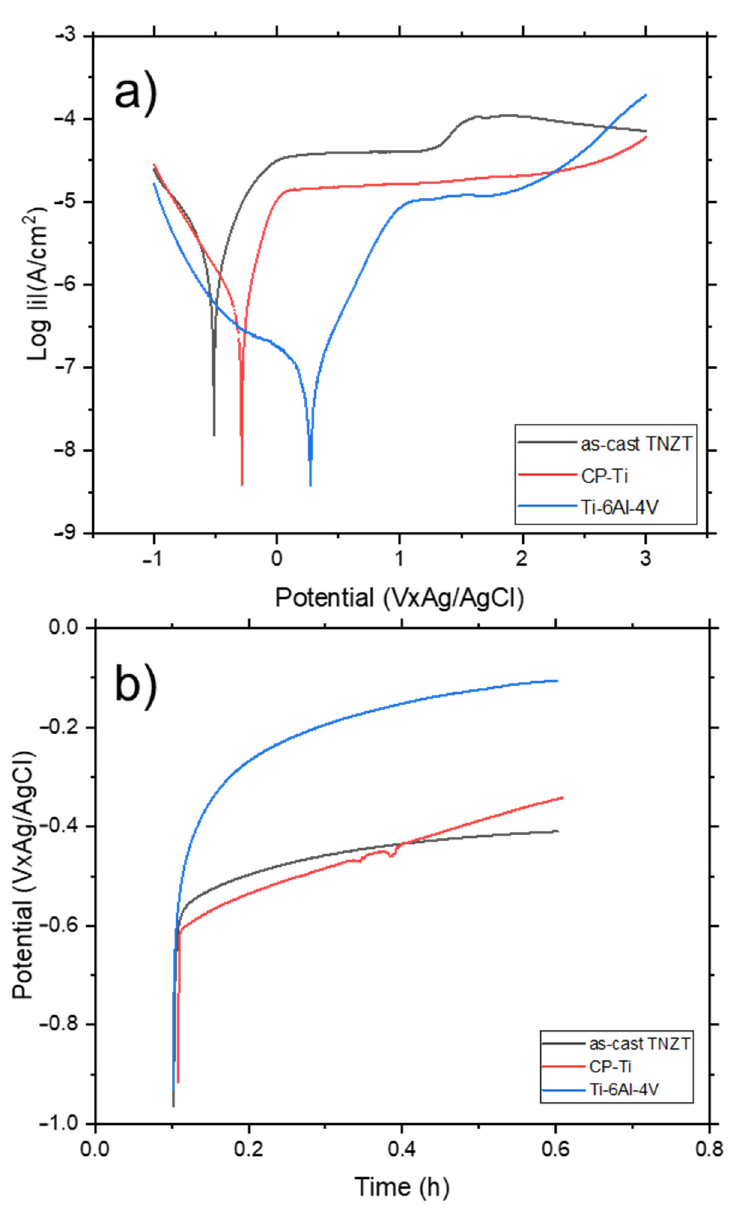
Figure 8. Representation of the OCP ( a ) and PPCs ( b ) curves of two cast TNZT alloy samples. The measurements were carried out in Ringer-Hartmann solution (pH = 6.8) at 37 °C.